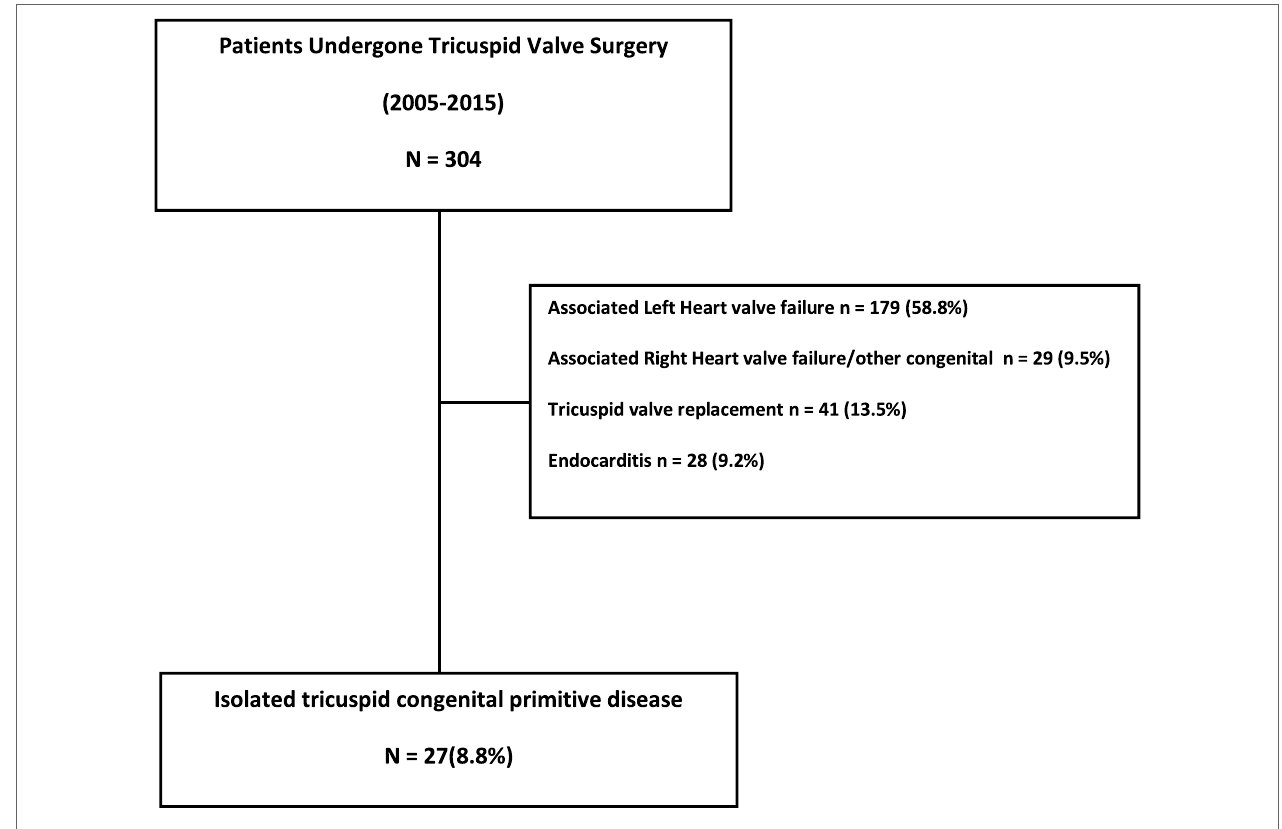
FigUre 1 | Patient selection and exclusion criteria